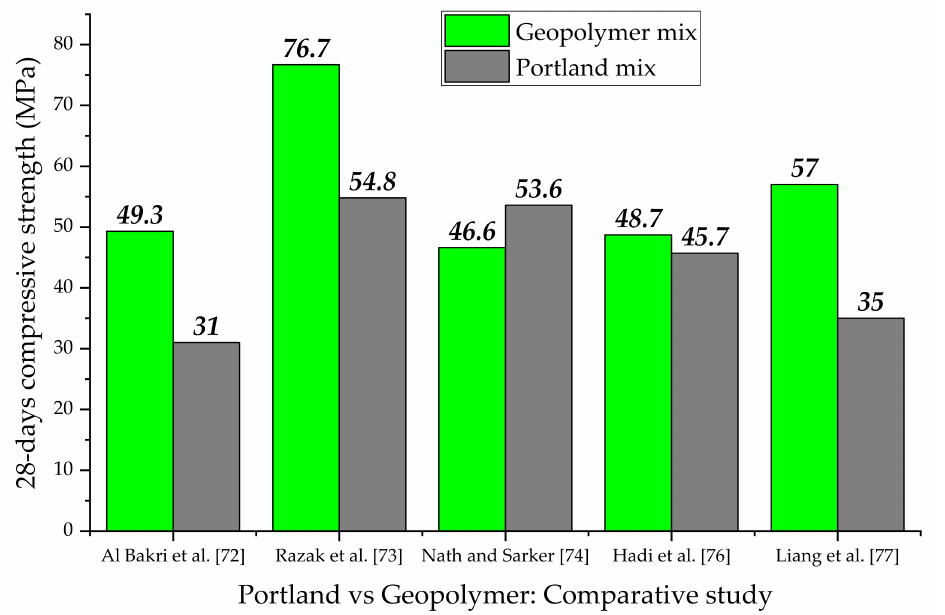
Figure 15. Comparison between Portland and geopolymer mixes in terms of strength proper- ties